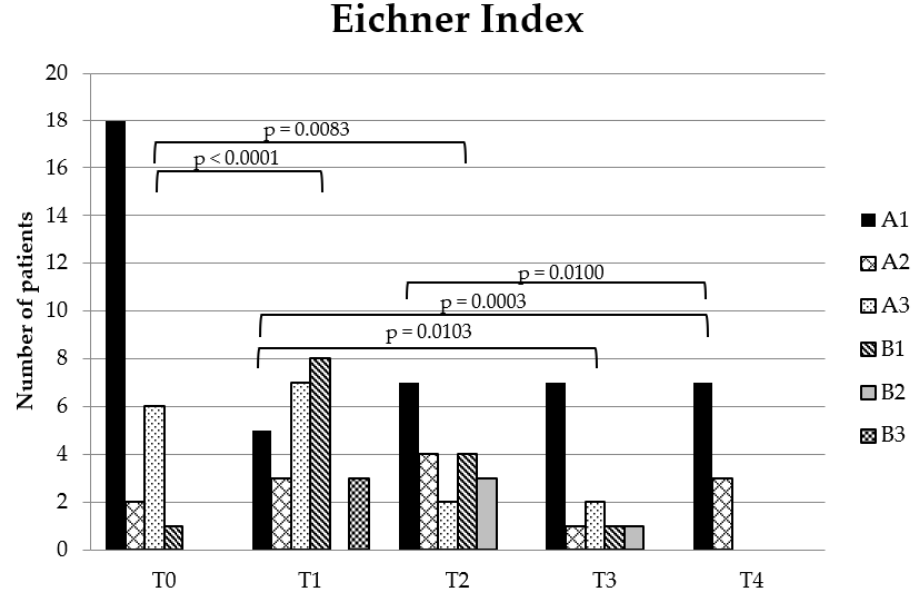
Figure 5. Eichner Index changes. The chart shows the number of patients in the Eichner Index groupings at the different treatment phases: pre-treatment (T0), 1st follow-up after bonding of fixed appliance (T1), during treatment (T2), post-treatment (T3) and at 1st retention follow-up (T4). The significant p -values are shown tested by a paired Wilcoxon test.